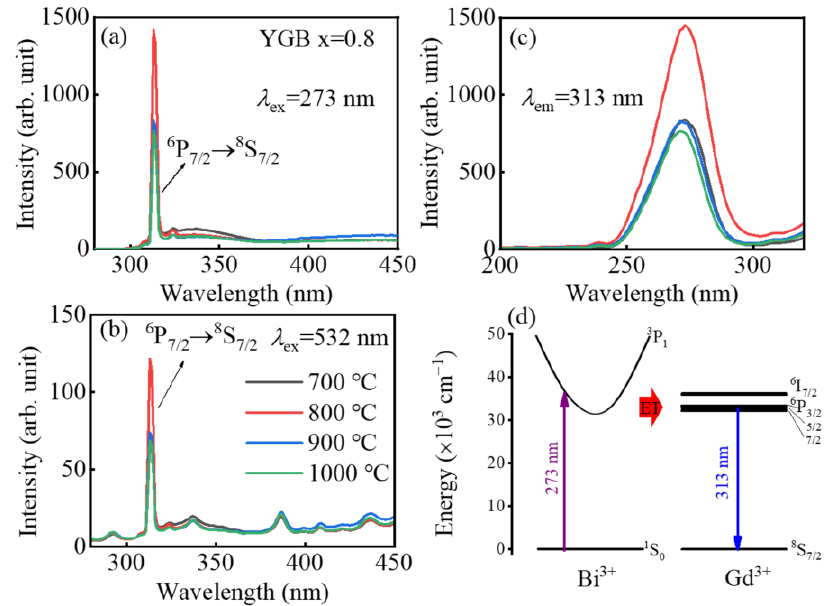
Figure 6. PL spectra of YGB-0.8 phosphors annealed from 700 °C to 1000 °C under ( a ) 273 nm and ( b ) 532 nm excitations. ( c ) Their PLE spectra monitored at 313 nm and ( d ) the schematic energy transfer mechanism from Bi 3+ to Gd 3+ ions.